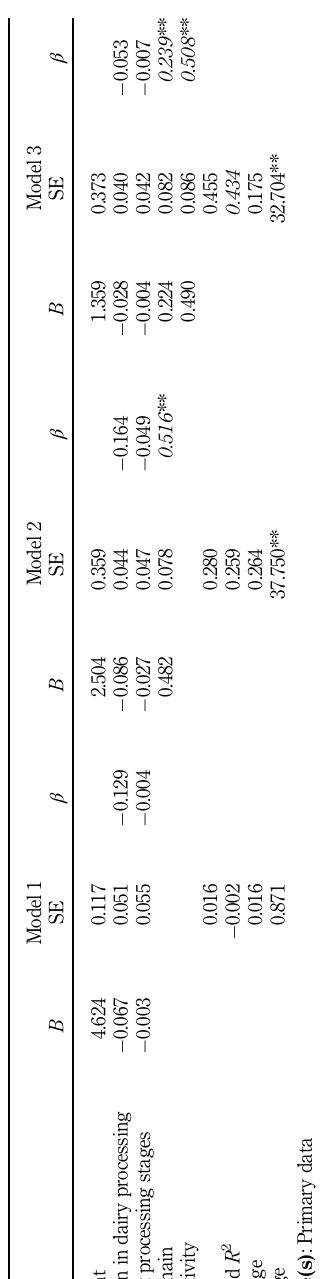
Table 4. Hierarchical regression